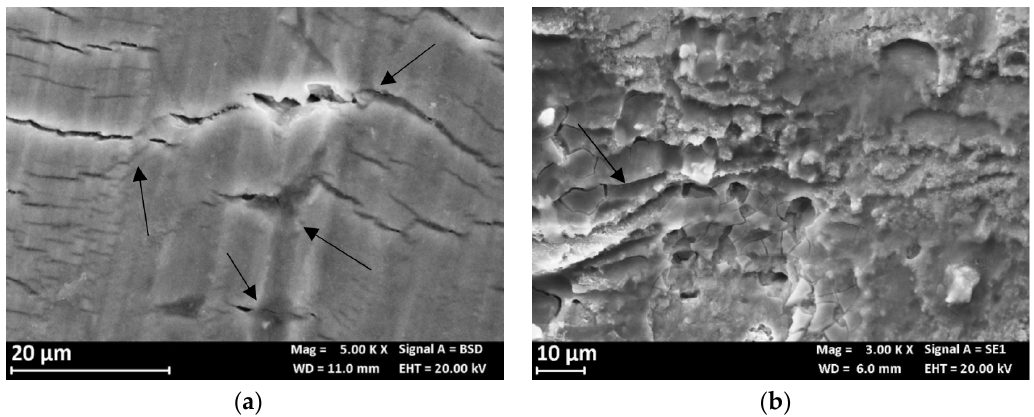
Figure 15 . SEM image of the fracture surface of the AA7075 T6 specimen after the SSR test ( a ) specimen surface with corrosion products of aluminum and several microcracks at macro ‐ precipitates (black arrows); ( b ) particular of fracture initiation zone after SSR test in 0.6 M NaCl solution.